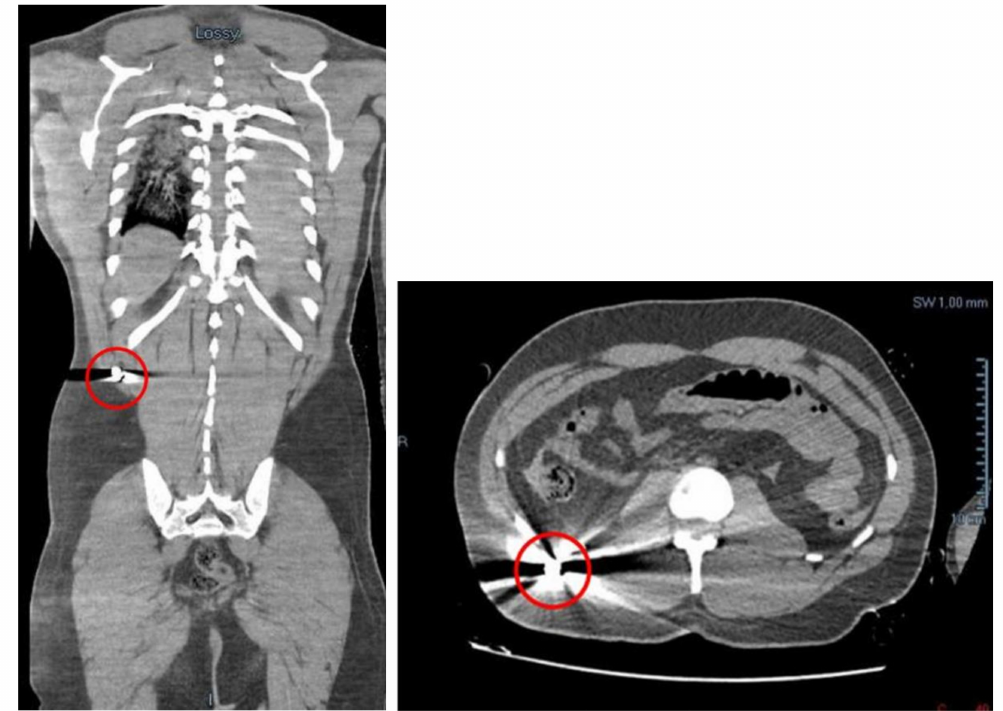
Figure 2. The retained bullet in the thickness of the posterior abdominal